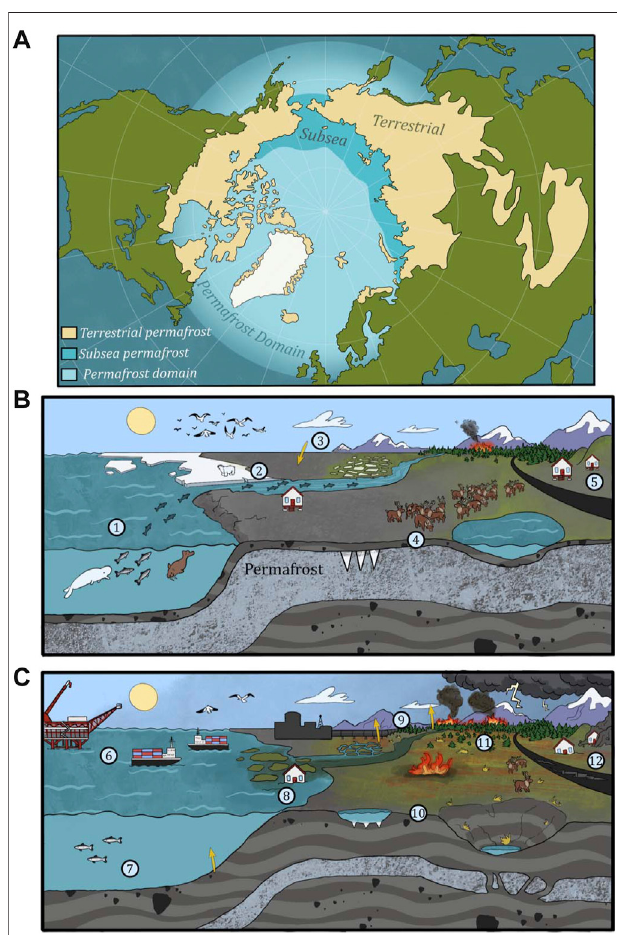
FIGURE 1 | The extent and example futures of the permafrost domain (A) Our de fi nition of the domain includes marine and terrestrial regions substantially affected by perennial frozen material, including oceans and seas above 50 ° N, subsea permafrost on the continental shelves, Arctic tundra, Boreal forest, and Alpine permafrost. The fi gure shows potential permafrost futures for (B) a rapid decarbonization scenario and (C) a continued fossil energy scenario. Panel B depicts: 1. Resilient biological communitiesinmarine,coastal,andterrestrialenvironments,2.Persistenceof sea ice, especially crucial multiyear and landfast ice, 3. Maintenance of net greenhouse gas uptake in the permafrost domain, 4. Recovery of permafrost and a shallow active layer, and 5. Preservation of human cultural activities and infrastructure. Panel C depicts: 6. Expansion of fossil fuel extraction and marine navigation, 7. Disruption of food webs, migrations, and biological communities on sea and land, 8. Accelerated coastal erosion, aquatic and marine primary productivity, ocean acidi fi cation, and erosion of terrestrial material,including pollutants, 9. Transition tonetrelease ofgreenhouse gases (CH 4 , N 2 O, and CO 2 ), 10. Extensive permafrostdegradation, including active- layer thickening and lake formation and draining, 11. Intensifying terrestrial disturbances including wild fi re, hydrological extremes, thermokarst, vegetation shifts, and invasive species, 12. Profound disruption of human culture and